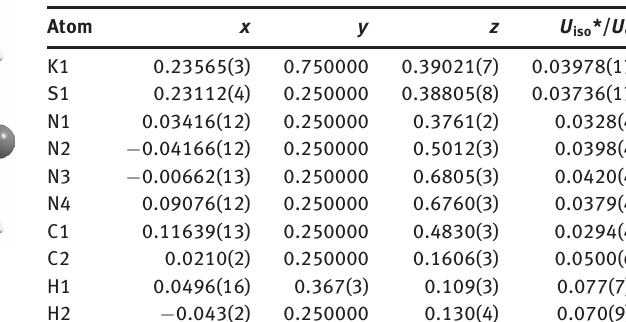
Table 2: Fractional atomic coordinates and isotropic or equivalent isotropic displacement parameters (Å 2